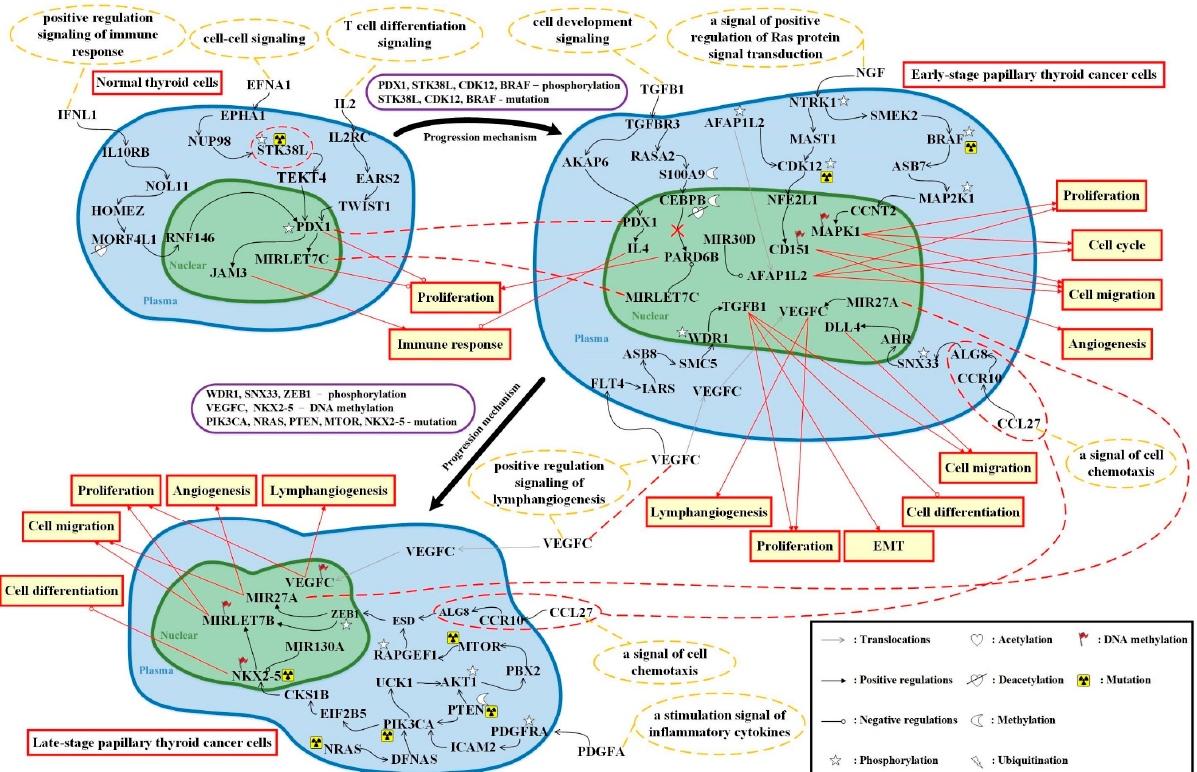
Int. J. Mol. Sci. 2019 , 20 , x; doi: FOR PEER REVIEW www.mdpi.com/journal/ijms Figure 3. The overview of the proposed carcinogenic progression mechanism from normal to late-stage papillary thyroid cancer cells. This figure summarizes the genetic and epigenetic progression mechanisms of papillary thyroid cancer cells in Figures 1 and 2. The upper horizontal part is the genetic and epigenetic progression mechanism from normal thyroid cells to early-stage papillary thyroid cancer cells; the top-right to bottom-left part denotes the genetic and epigenetic progression mechanisms from early-stage papillary thyroid cancer cells to late-stage papillary thyroid cancer cells; the red rectangle with yellow background represents cellular functions; the purple rounded rectangle indicates the biomarker to induce genetic and epigenetic progression mechanism of successive stages; the yellow dashed ellipse circles represent the microenvironment; the red dash lines denote biomarkers that appear in two consecutive stages of papillary thyroid cancer cells; the black arrow lines represent the protein–protein interaction or transcriptional regulation; the black circle head of lines indicates miRNA downregulation by miRNA; the red arrow lines represent the genes to induce cellular function; the red circle head of lines indicates the genes to repress cellular